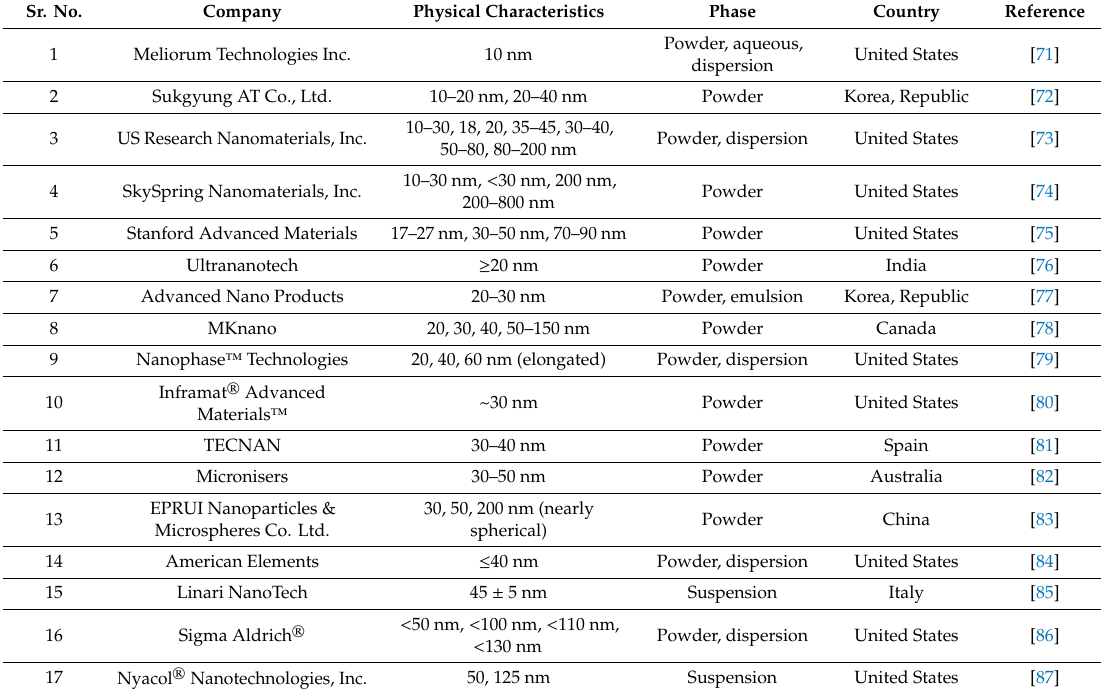
Table 2. Some of the major ZnO NPs